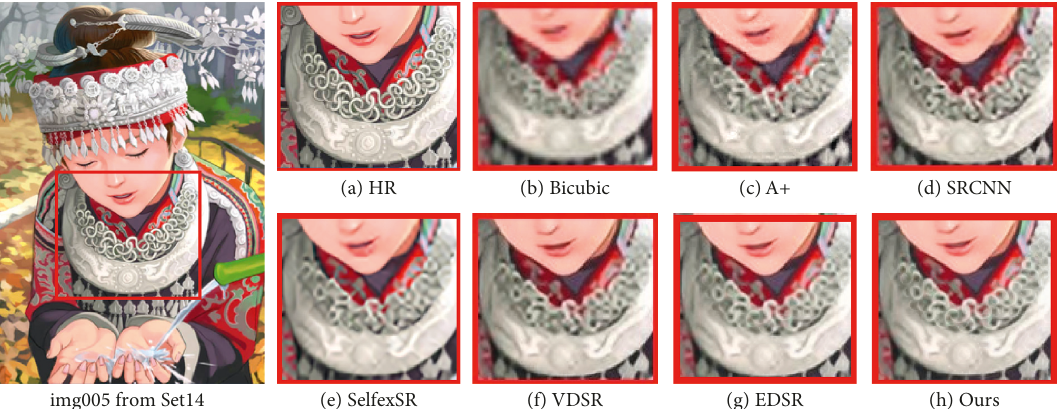
Figure 7: Super-resolution results of “img005” from Set14 with scale factor 3. Partially enlarged view of the picture in the red box on the